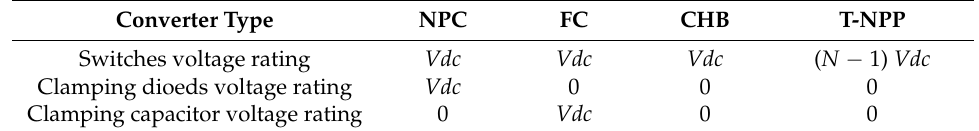
Table 6. Comparison between NPC, CHB, FC and T-NPP in terms of rating requirement per level n.